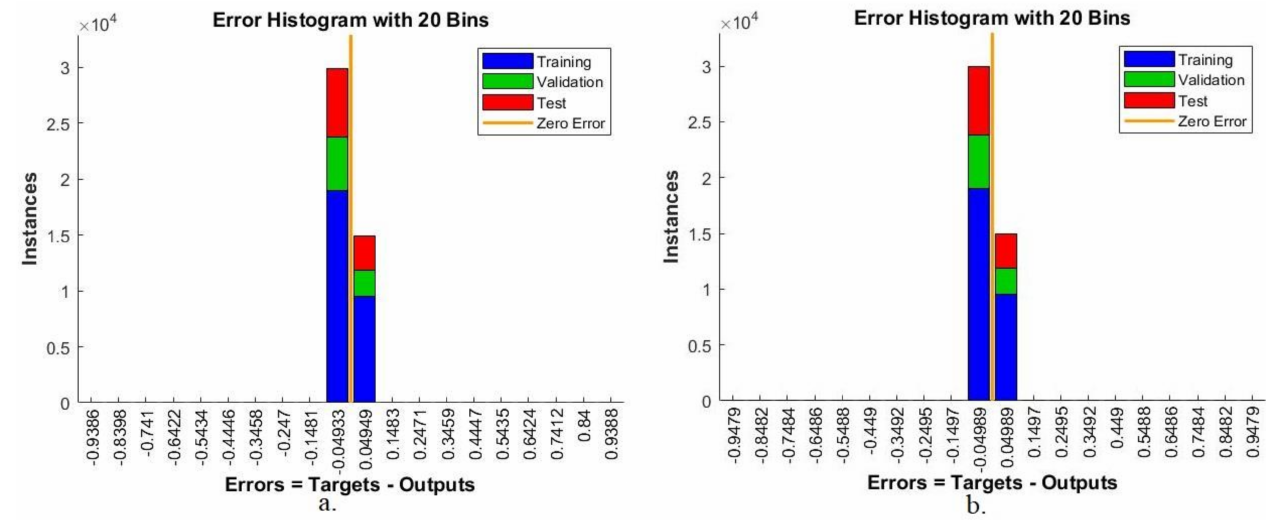
Figure 9. A display of the error histogram evaluating the first dataset based on mixed features in ( a ) DenseNet-121 and hand-crafted features and ( b ) ResNet-50 and hand-crafted